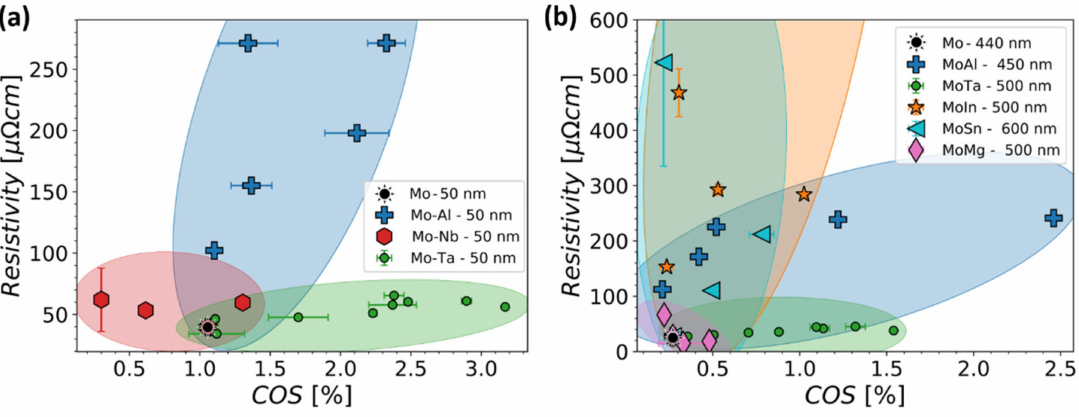
Figure 10. Map of electrical resistivity versus COS for ( a ) 50 nm and ( b ) 500 nm thick Mo-based alloy film systems with different chemical compositions. The highlighted areas act as guides for the eye to collect similar alloy systems and have no mathematical or statistical